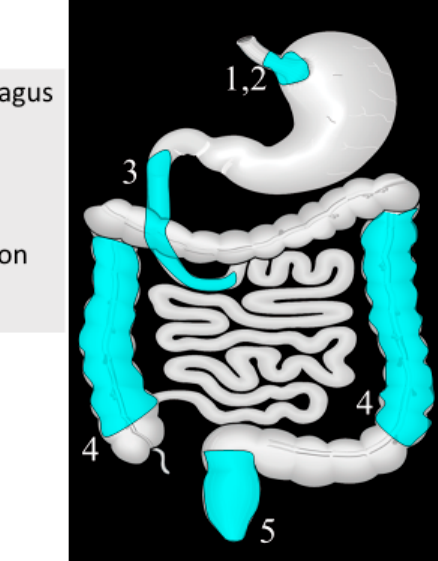
Figure 1. Fixed part in each bowel organ in systematic scanning. The cervical and abdominal esophagus in esophagus, parts of cardia and pylorus in stomach, descending part in duodenum, ascending and descending colon in large intestine, and rectum.